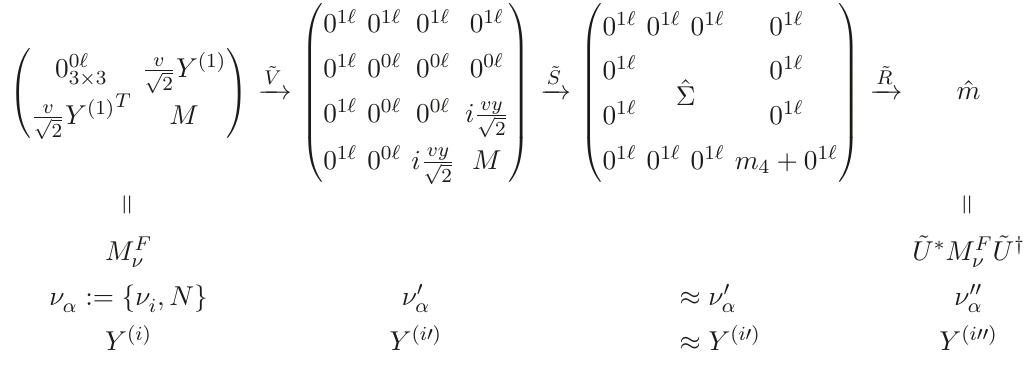
. Explicit entries show quantities ν loop are loop and m 3 m 4 × × ν ′ at one-loop i → j . m 4